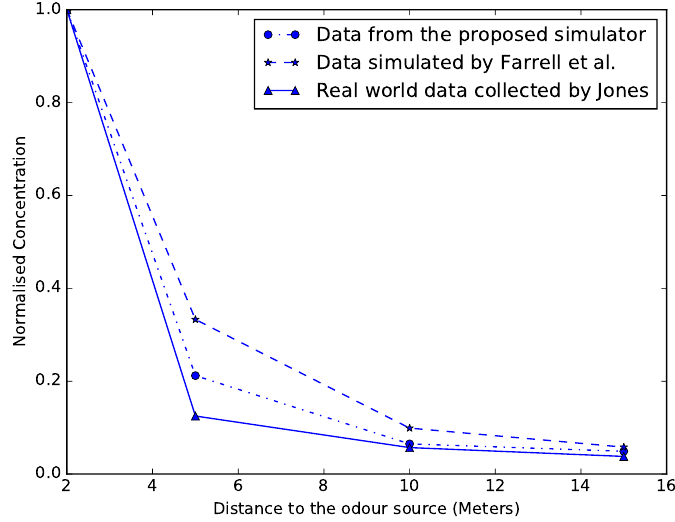
Figure 5. Plot of the chemical concentrations sensed at 2, 5, 10 and 15 m downwind from the source, averaged over 600 s. Each dataset is normalised by the data collected at 2 m downwind from the